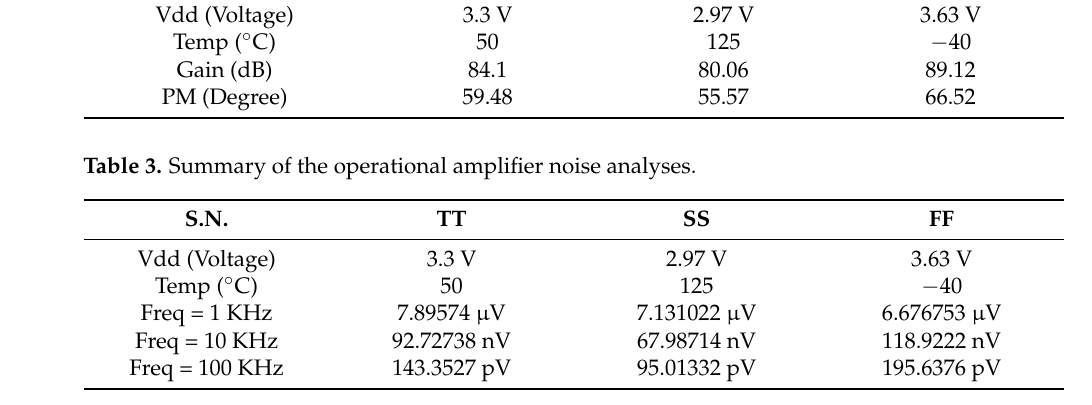
Table 2. Summary of the operational amplifier PVT analysis.